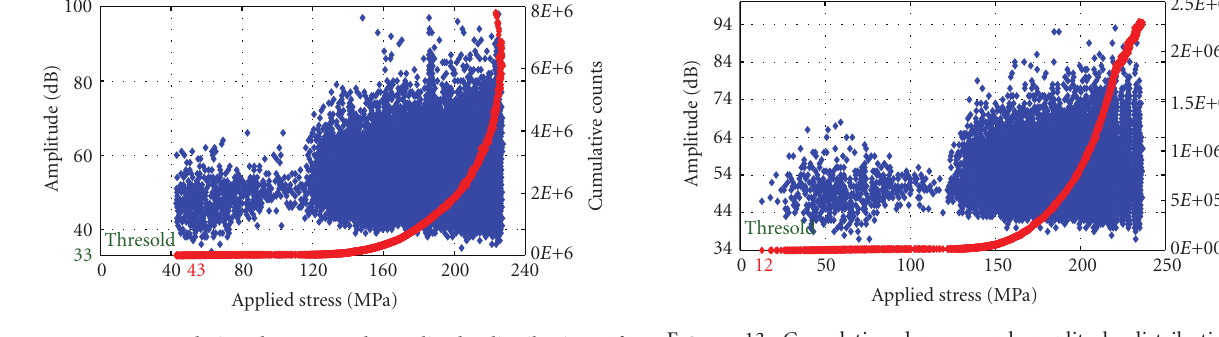
Figure 12: Cumulative damage and amplitude distribution of acoustic events in samples without integrated device.